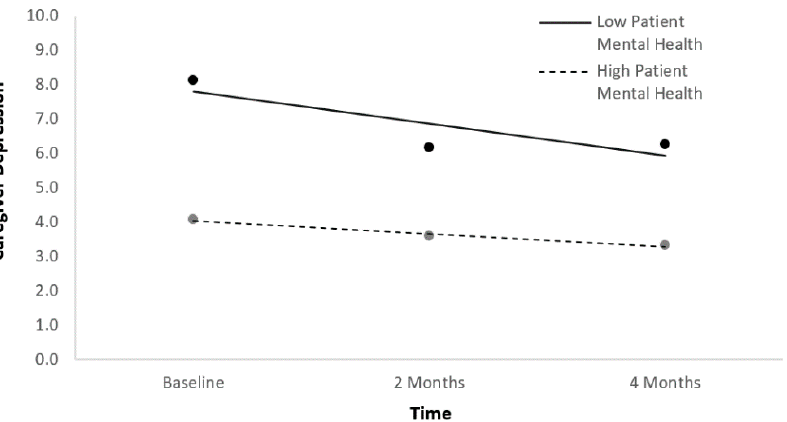
Figure 2. Caregiver depression symptom trajectories as a function of patient mental